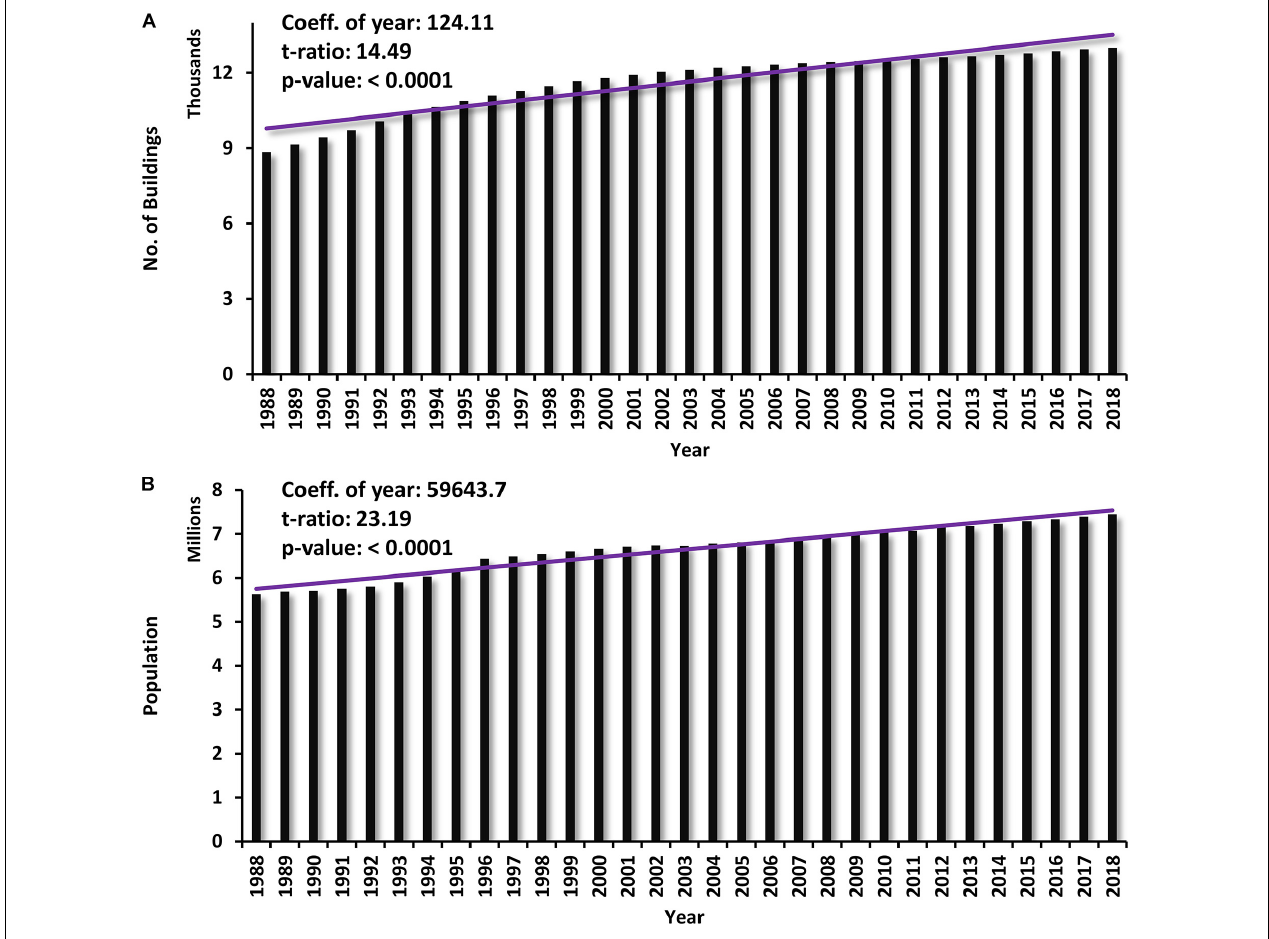
FIGURE 5 | Time series of number of buildings in Hong Kong (A) and population (B) .